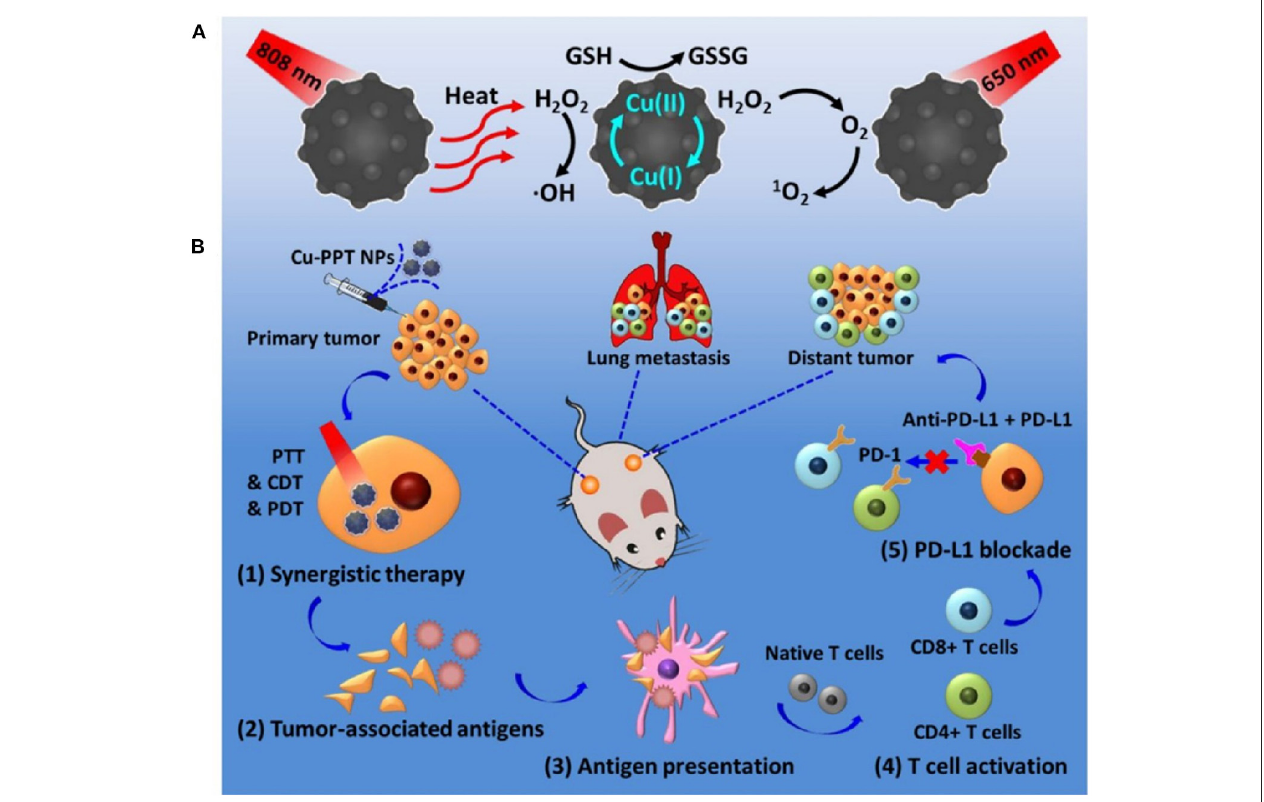
FIGURE 11 | Schematic representation of Cu-PPT based synergistic anticancer effect with photothermal therapy, photodynamic therapy, and chemodynamic therapy (A) . Mechanism of Synergistic therapy triggers the release of tumor-associated antigens and PD-1/PD-L1 combination induced a robust antitumor immunity (B) . Reproduced with permission from Hu et al. (2020) under Copyright © 2020, American Chemical Society